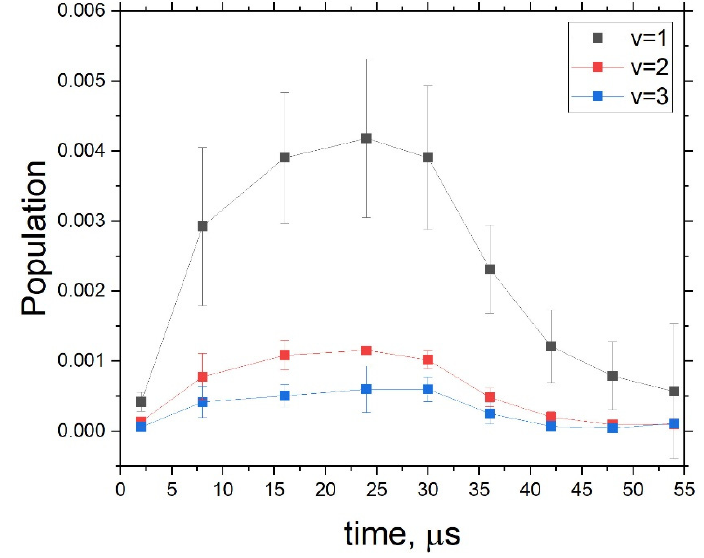
Figure 11. Vibrational populations of OH four vibrational states calibrated to the theoretical spectra using Equation (6) (assuming T R = 500 K).